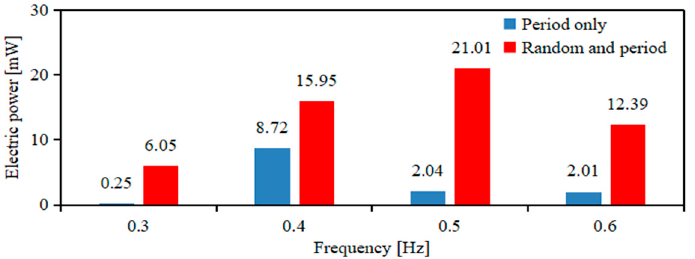
Figure 17. Results of comparing average electrical power. (The blue graph is the result of vibration with a periodic signal. The red graph is the result of vibration with random and periodic signals.)